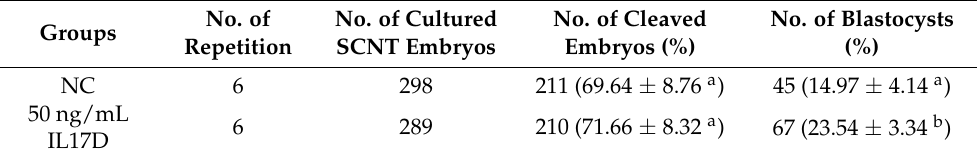
Table 4. Developmental efficiency of IVF embryos treated with IL17D at 1-cell stage for 48 h. No. of No. of Cultured No. of Cleaved No. of Blastocysts Groups Repetition SCNT Embryos Embryos (%)